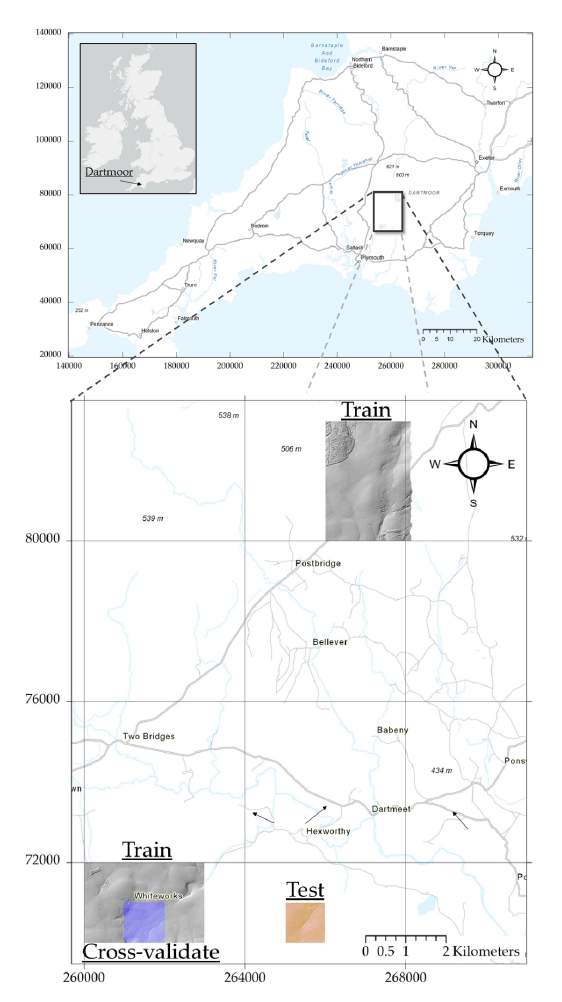
Figure 2. Study area and dataset locations. Base DSM ©